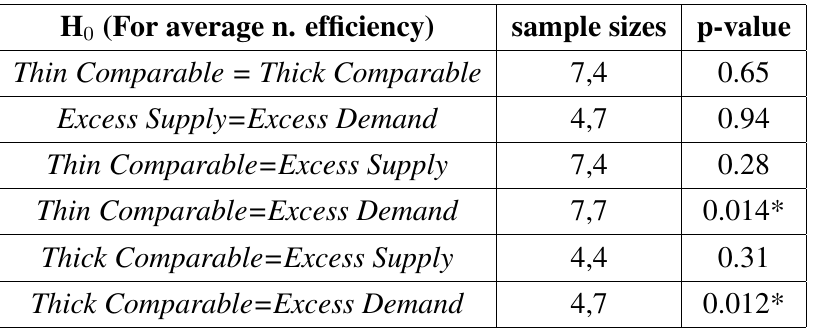
Table 9. Testing equality of normalized efficiency in the last five